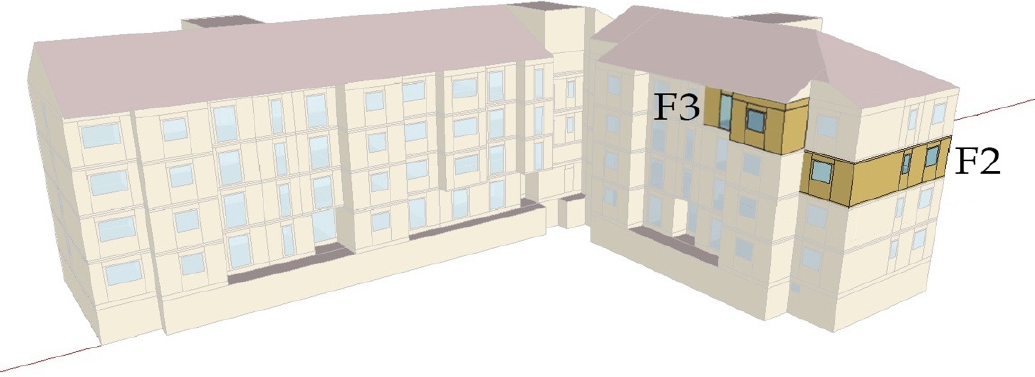
Figure 2. A 3D geometric model of the building highlighting the flat located on the second floor (F2) and the flat on the third floor (F3).